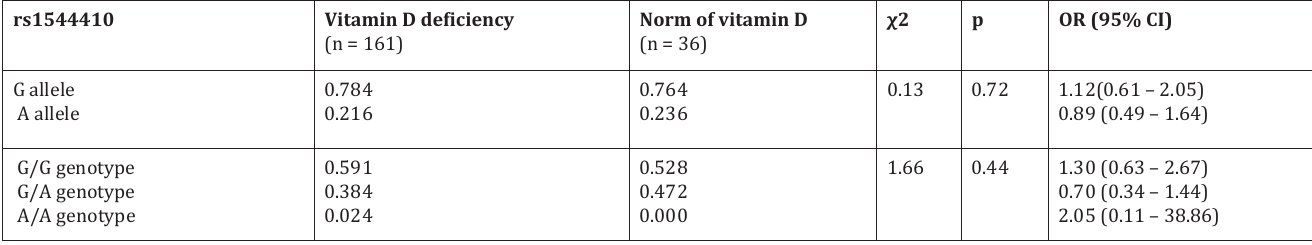
Frequency distribution of genotypes and alleles of the VDR rs1544410 depending on the level of vitamin D